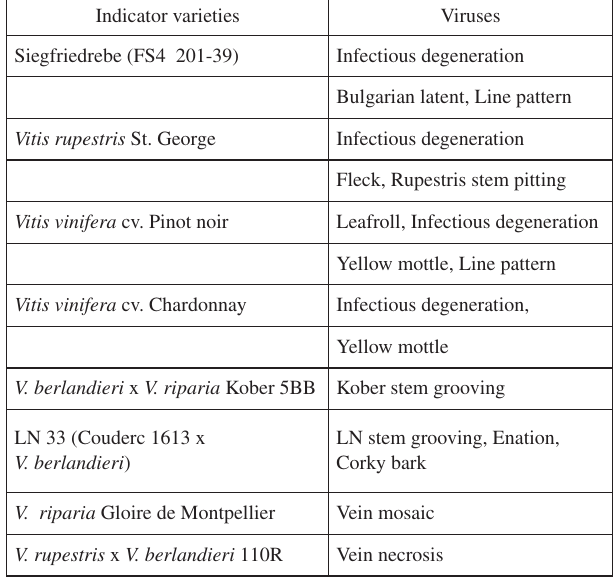
Table 2. Indicator varieties used for the identification of the main virus and virus-like diseases of the grapevine Indicator